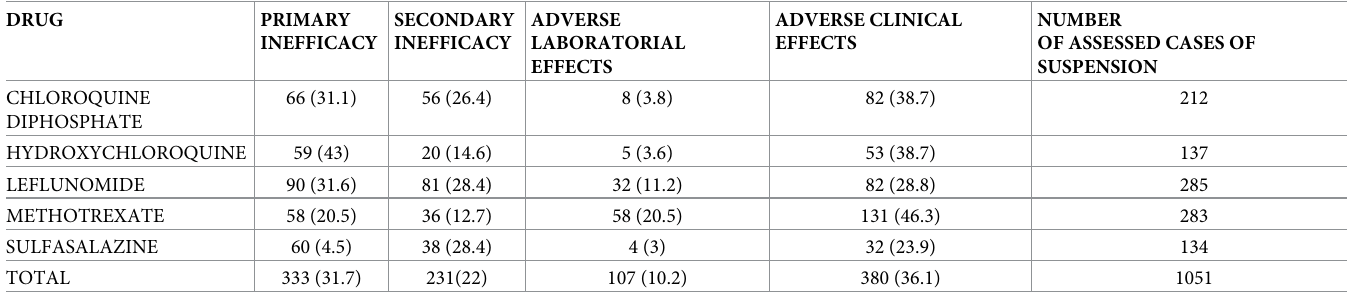
Table 3. Medical causes of interruption of synthetic DMARDs